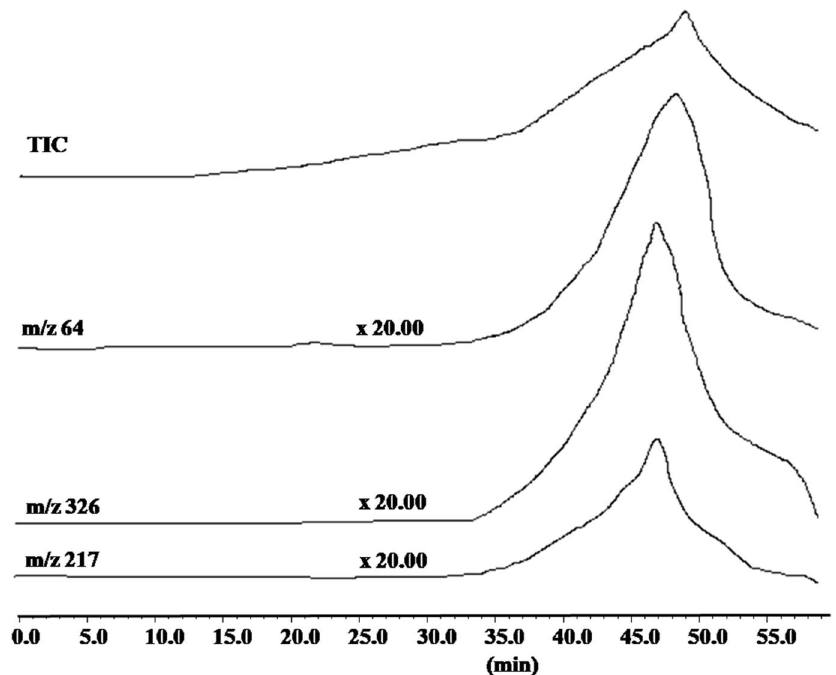
Figure 3. Total ion current (TIC) trace and single ion curves (SIC) of the ions at m / z 64, 326 and 217 evolved in the EI-DPMS of the P(ESES) homopolymer.